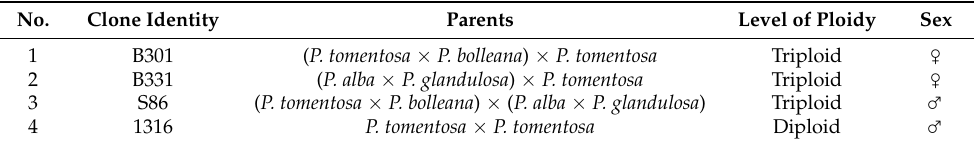
Table 1. Identity and origin of the hybrid